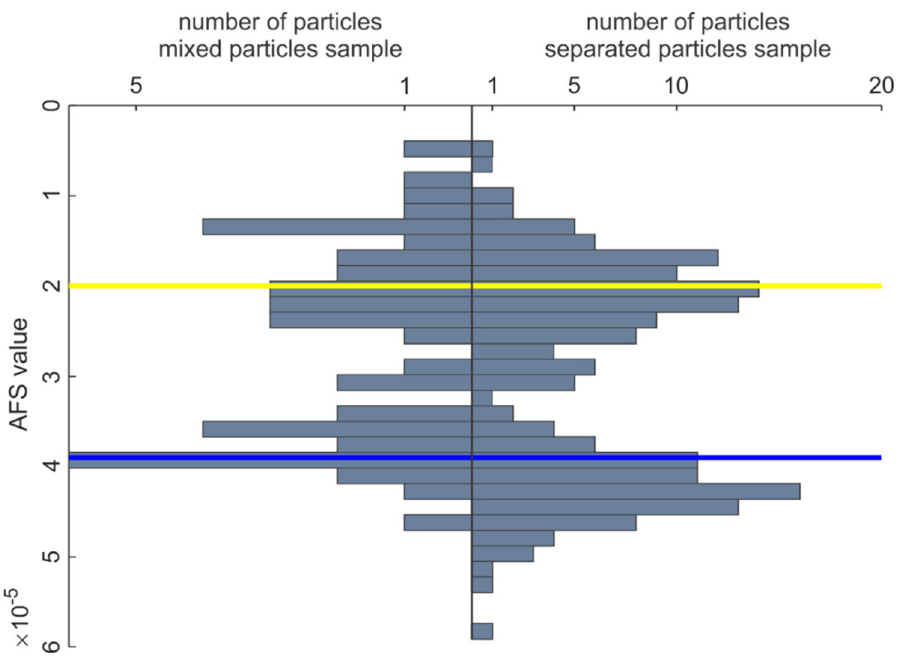
Figure 12. Histogram of particle AFS values for the sample with mixed particles (left) and the sample with separated particles (right). The yellow and blue lines represent the AFS value for the disk samples with 150 nm and 50 nm pores,